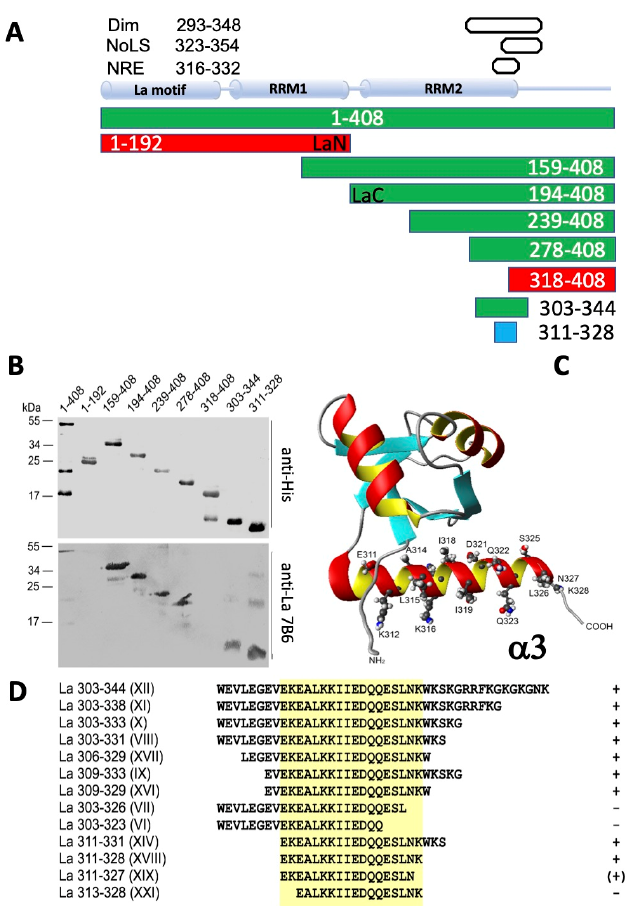
Figure 3. The epitope recognized by the anti-La mAb 7B6 is part of the predicted dimerization domain (Dim), nuclear retention element (NRE) and nucleolar localization signal (NoLS). ( A ) A series of deletion mutants, which were truncated from either the N- or the C-terminus or from both sites, were cloned as His-tagged fusion proteins, expressed in E. coli and isolated by nickel affinity chromatography. ( B ) The deletion mutants were tested against either anti-His Abs (upper panel) or the anti-La mAb 7B6 (lower panel). Results for selected deletion mutants are shown, including the identified epitope sequence aa311-328 (EKEALKKIIEDQQESLNK). ( C ) The epitope sequence consists of most of the α 3-helix in the RRM2 plus 3 aa (LNK) of the unstructured region located C-terminally of the α 3-helix (see also Figure 1). ( D ) Besides the deletion mutants shown in ( A , B ), a series of further fragments related to the epitope sequence recognized by the anti-La mAb 7B6 were prepared and tested, which finally helped us to locate the epitope recognized by the anti-La mAb 7B6 to the aa311- 328.